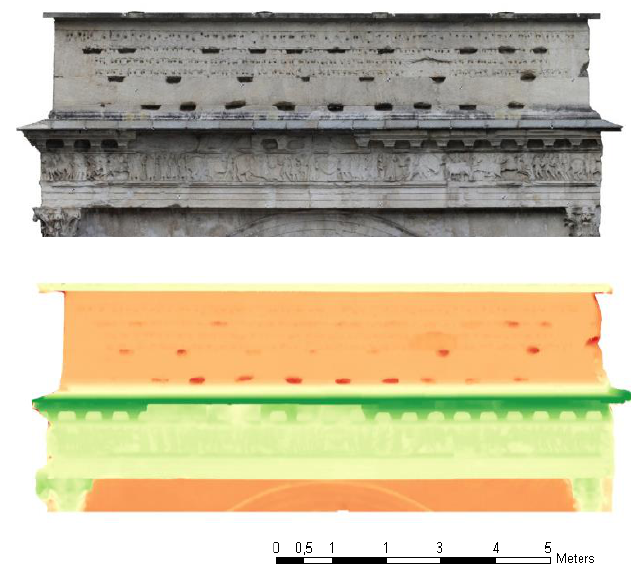
Figure 6. The achieved orthophotos and DSM (MicMac above and Photoscan